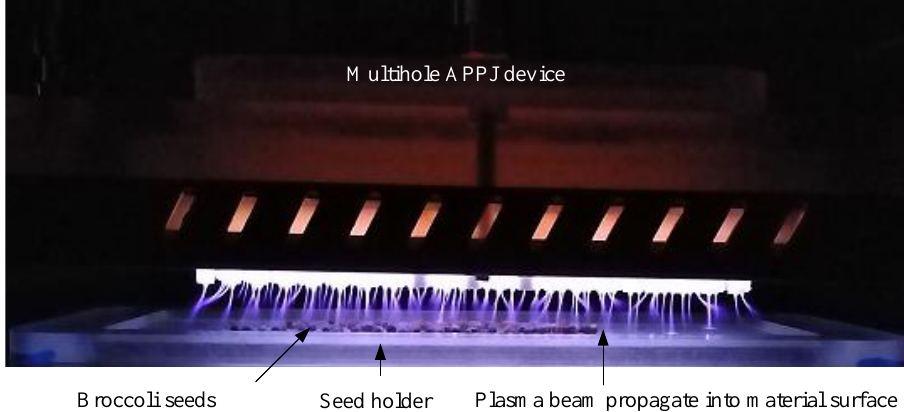
Figure 5. Photograph during the multihole plasma jet exposure of the broccoli seeds.